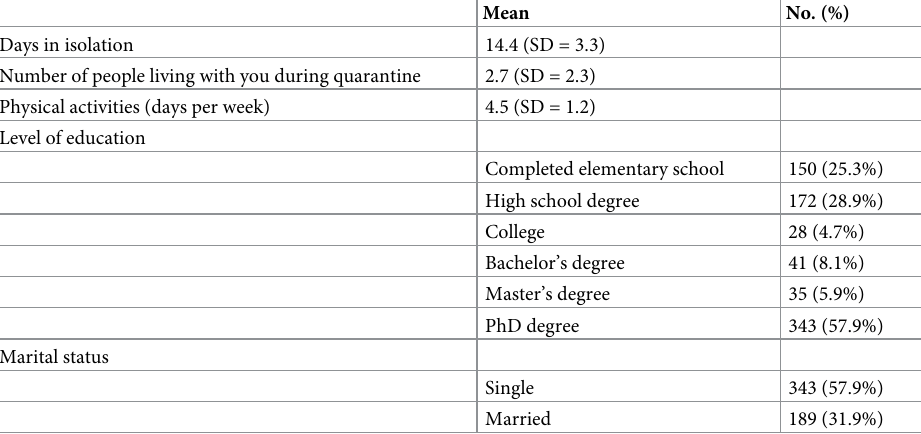
Table 1. Demographics characteristics of the